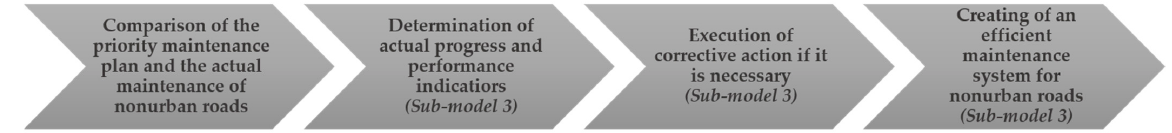
Figure 7. Summary view of the monitoring and control management process.